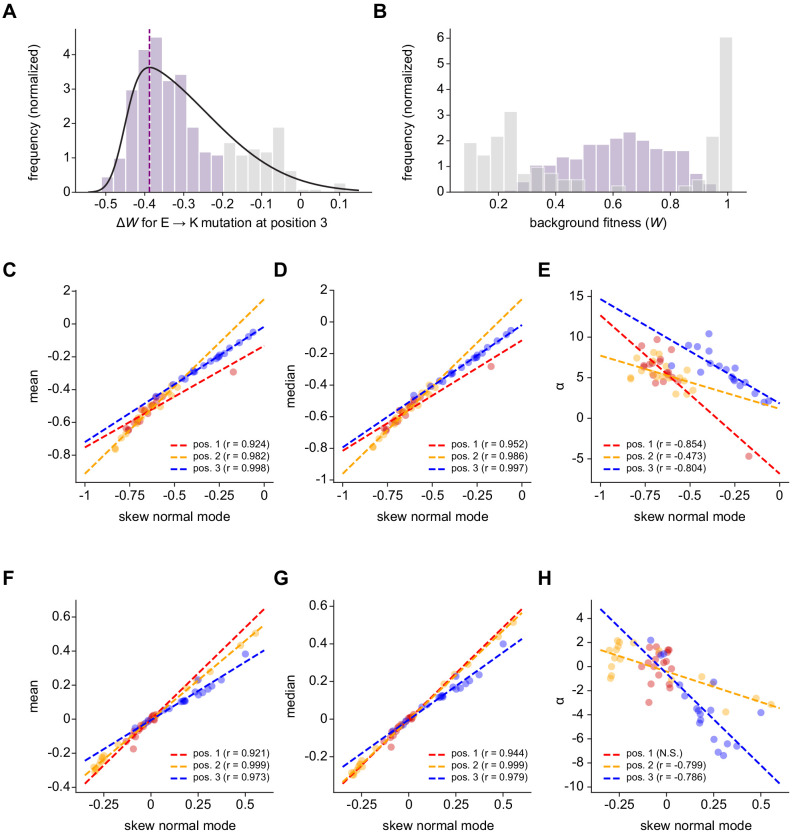
Characterizing the distribution of fitness effects for every amino acid substitution in the ParD3 library.(A–B) Distribution of fitness effects (∆W) versus. ParE3 for an example substitution type, E → K at library position 3 (A). Fit to a skew normal distribution is plotted in black; dashed purple line indicates the mode of the distribution. (B) Histograms showing the fitness of variants in which the substitution occurs (i.e., variants with E at position 3). In both (A) and (B), variants for which ∆WE → K ≥ -0.20 are shown in gray and ∆WE → K < -0.20 are shown in purple. (C–E) Comparison of the mode to other measurements of central tendency (C–D) and α, a measure of skewness (E). Each point summarizes the distribution of fitness effects versus. ParE3 for a given substitution type. Dashed lines are regression lines; Pearson r is indicated. (F–H) Same as C-E, but for ParE2.